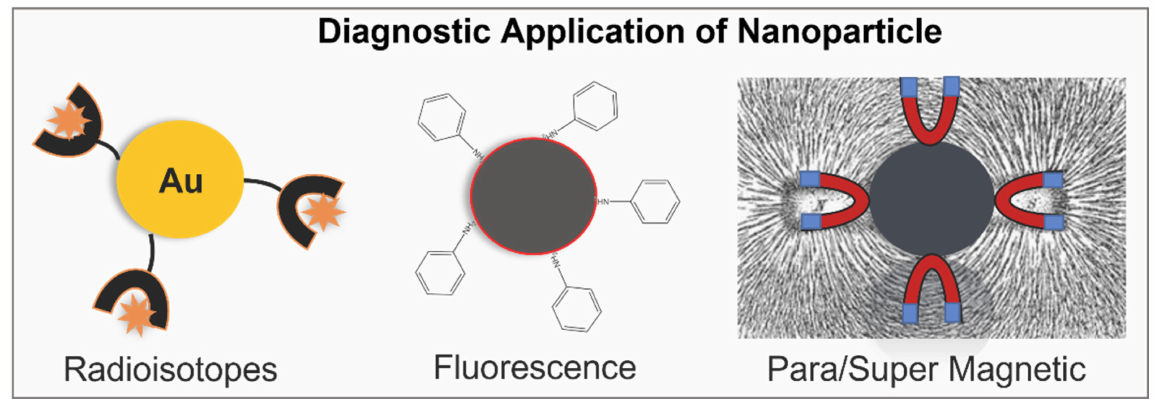
Figure 2. Surface modifications of metallic/metalloids NPs for cancer imaging